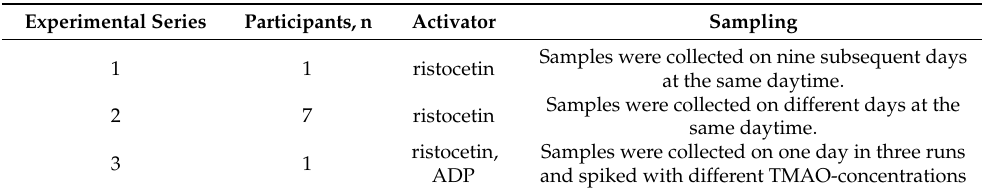
Table 1. Platelet activation experiment, experimental series.